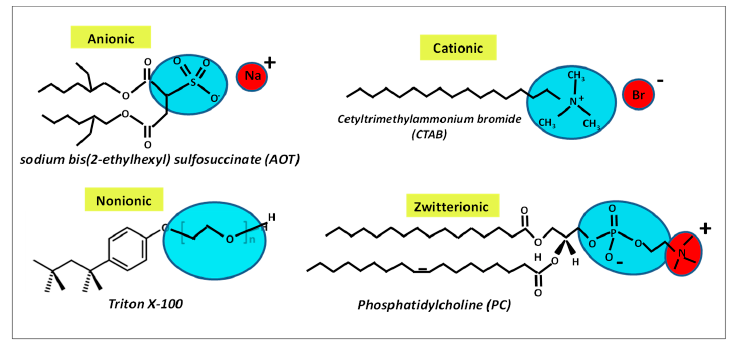
Figure 3. Example of traditional charged (anionic/cationic/zwitterionic) and uncharged (nonionic) amphiphilic molecules.